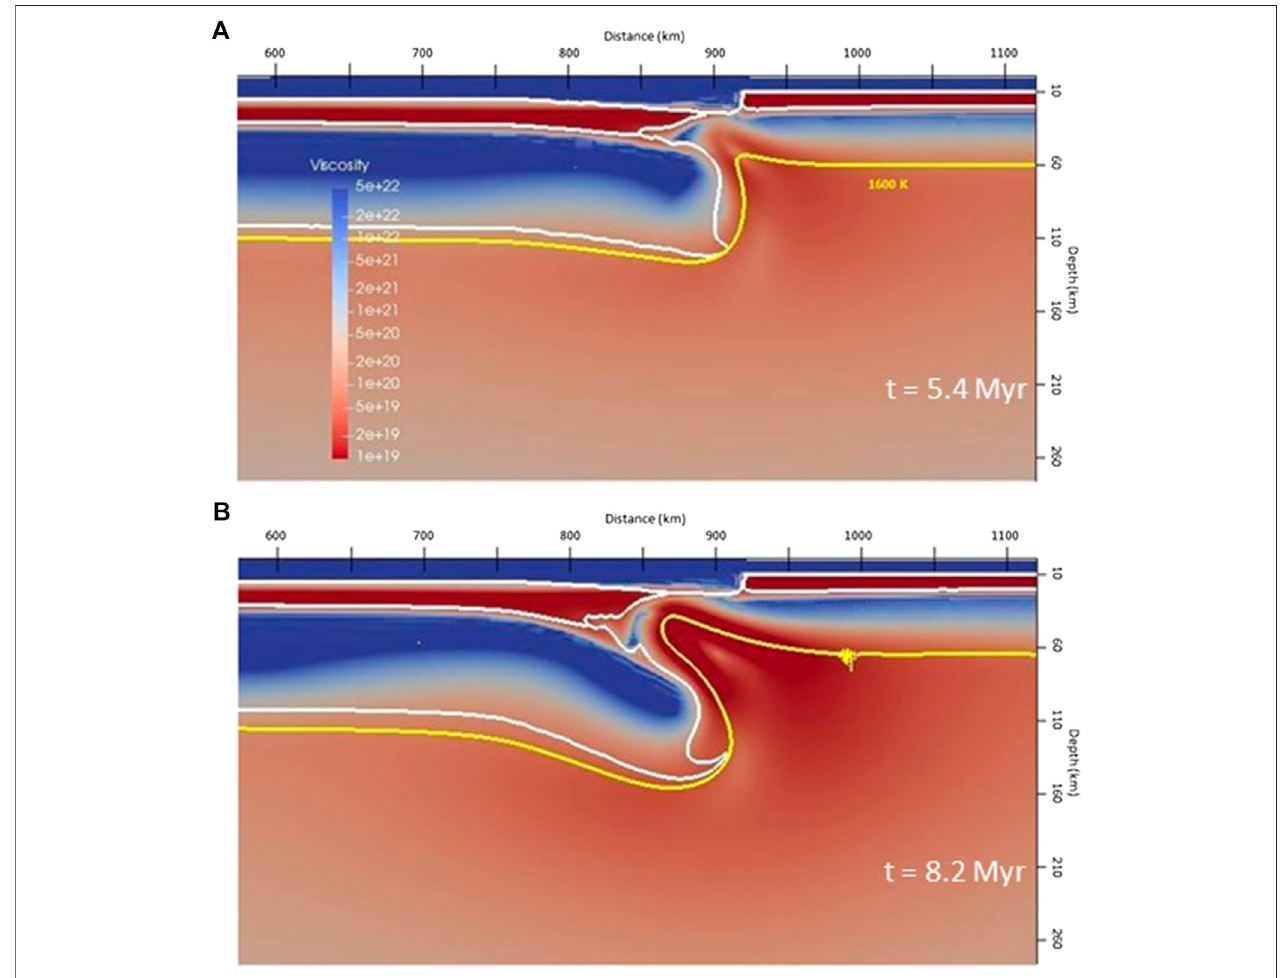
FIGURE10| Distributionofviscosity(logarithmicscaleplot;Pasunits)andlocationofthe1,600 Kisothermatdifferenttimes (A) 5.4 Myr(forcomparisonpurposes with the fi nal time of the Reference Model), (B) 8.2 Myr of the “ Slow Model. ”